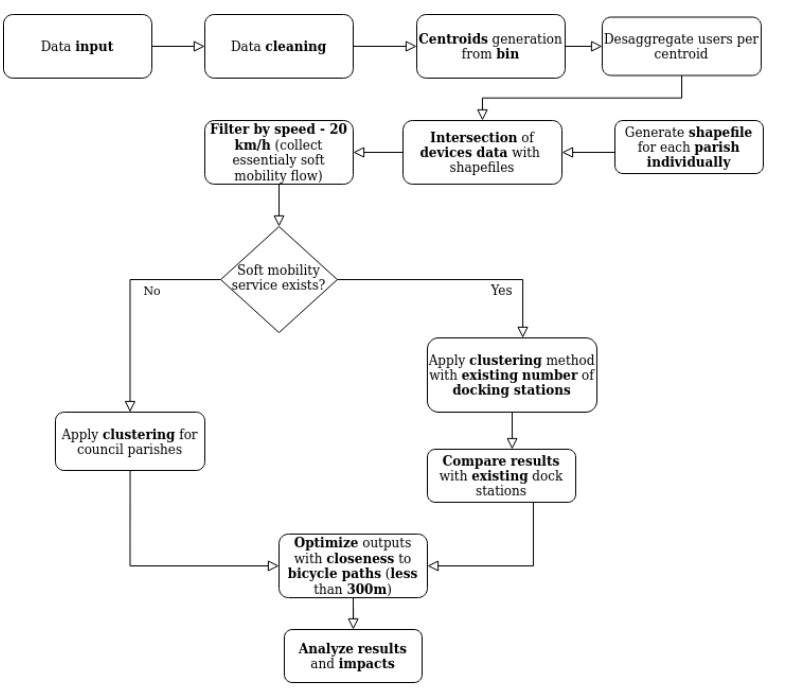
Figure 7. Methodology applied in the current study. Source: